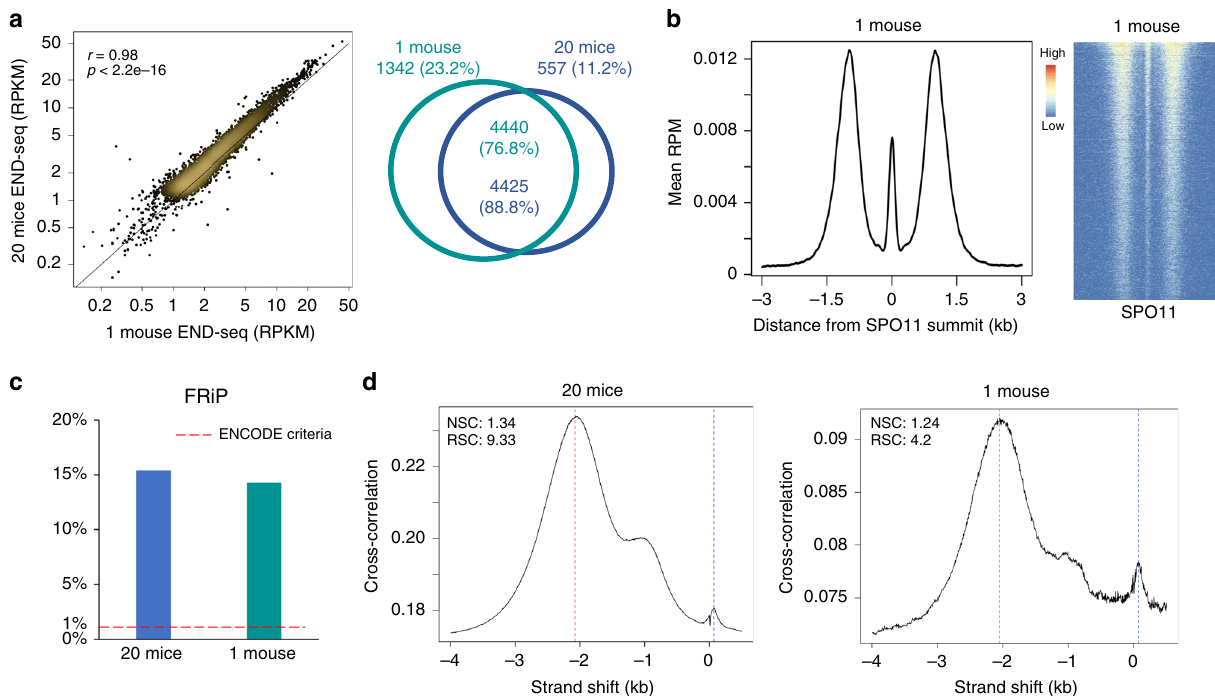
Fig. 3 END-seq detects meiotic DSBs in a single mouse. a Left panel: correlation (Pearson ’ s r ) between END-seq RPKM from 20 mice versus RPKM from one 12 dpp mouse ± 3 kb around SPO11 summits. Right panel: Venn diagram overlap of called peaks between 20 mice and one mouse. P value < 2.2e-16, Fisher ’ s exact test. b Left panel: Full END-seq break pattern in aggregated signal from one mouse, centered around SPO11 oligos. Right panel: heatmap of END-seq signal from one mouse in a ± 3 kb window around SPO11 oligos, ordered by total read count. c FRiP values for 20 mice versus one mouse. Recommended ENCODE value denoted by dotted red line. d Cross-correlation plot pro fi les for 20 mice and one mouse. The plot shows Pearson cross- correlations (CCs, y axis) of read intensities between the plus strand and the minus strand, after shifting minus strand ( x axis). One peak corresponds to read length (CCread, blue dash line) and the other one corresponds to the fragment length (CCfrag, red dash line). Normalized strand coef fi cient (NSC) is CCfrag divided by minimal CC value (CCmin) and relative strand coef fi cient (RSC) is the ratio of CCfrag-CCmin divided by CCread-CCmin. Higher NSC and RSC values mean more enrichment. ENCODE ’ s recommendation for ChIP-seq: NSC ≥ 1.05 and RSC ≥